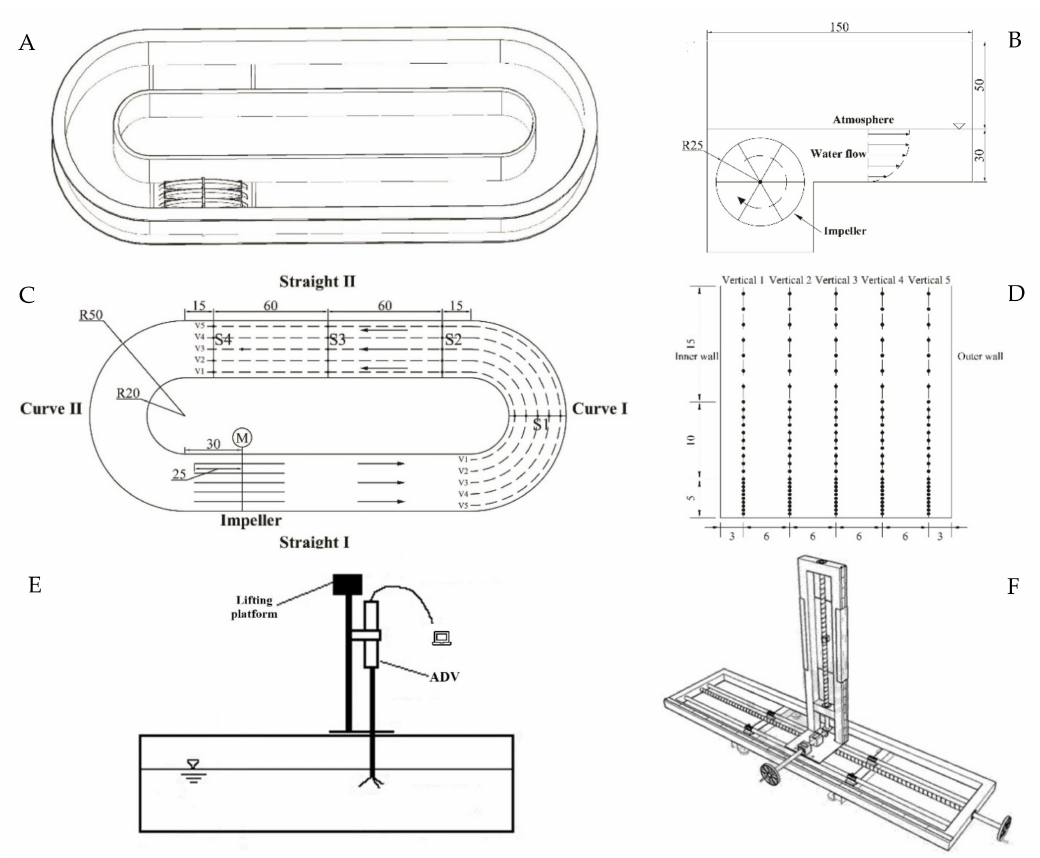
Figure 1. Schematic diagram of circular flume and arrangement of measuring points. ( A ) Generalization of physical model of flume, ( B ) working schematic, ( C ) layout of measuring section and vertical line, ( D ) arrangement of measuring points on each vertical line, ( E ) schematics of the velocity measurement system, ( F ) schematics of the lifting